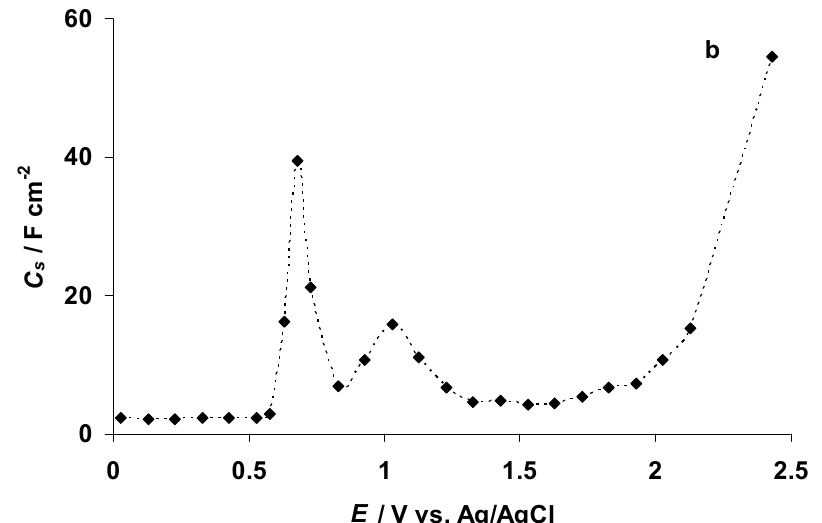
Figure 15. Data obtained from electrochemical impedance spectroscopy measurements: ( a ) parallel capacitance ( C p ) and ( b ) series capacitance ( C s ) values (calculated at ν = 0.95 mHz) for the 5 wt % EMImBr solution in the EMImBF 4 –C(Mo 2 C system at various positive potentials.